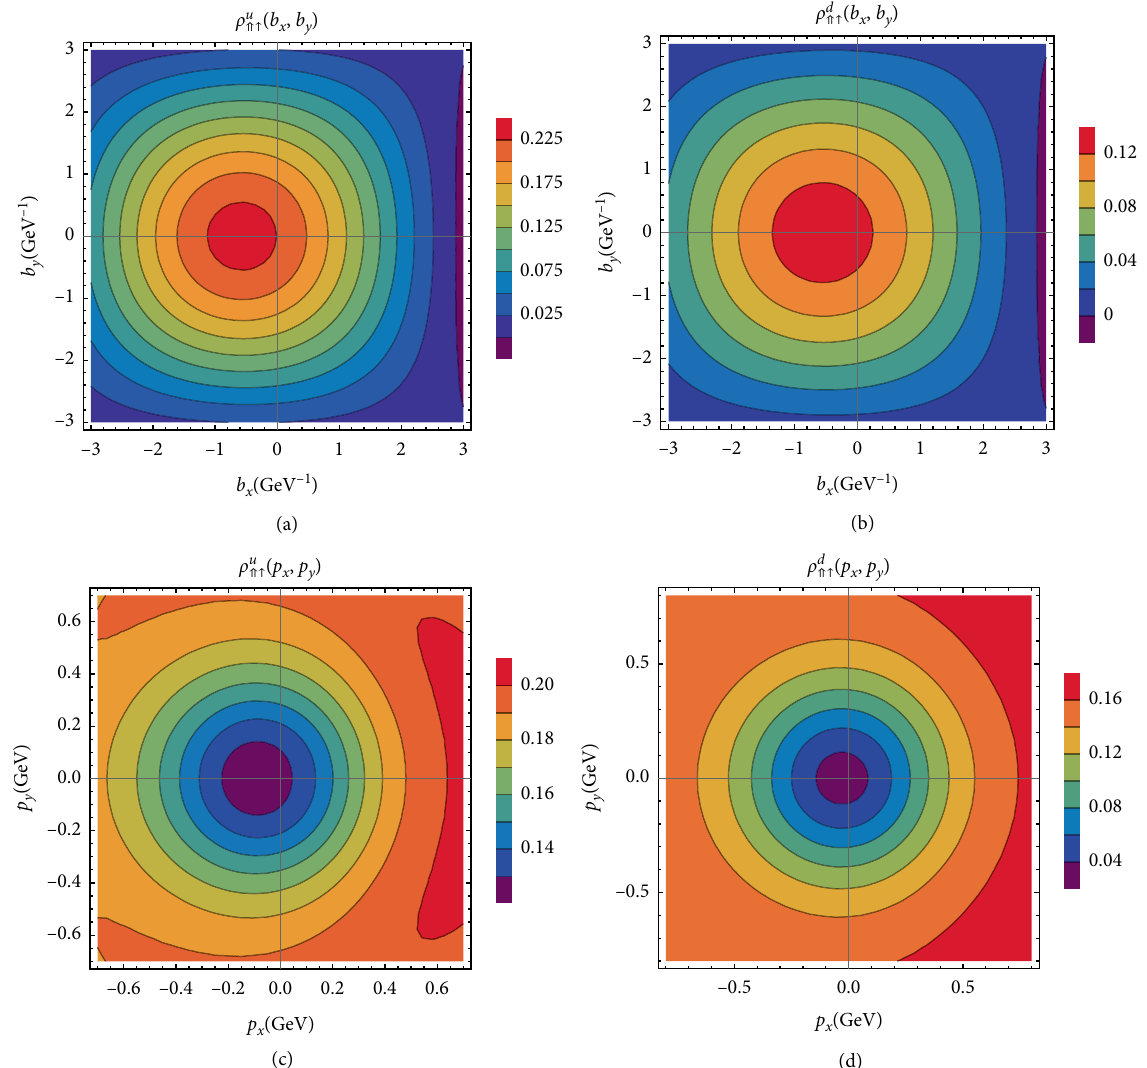
Figure 6: The plot of Wigner distribution 휌 (left panel) and 𝑑 -quark (right